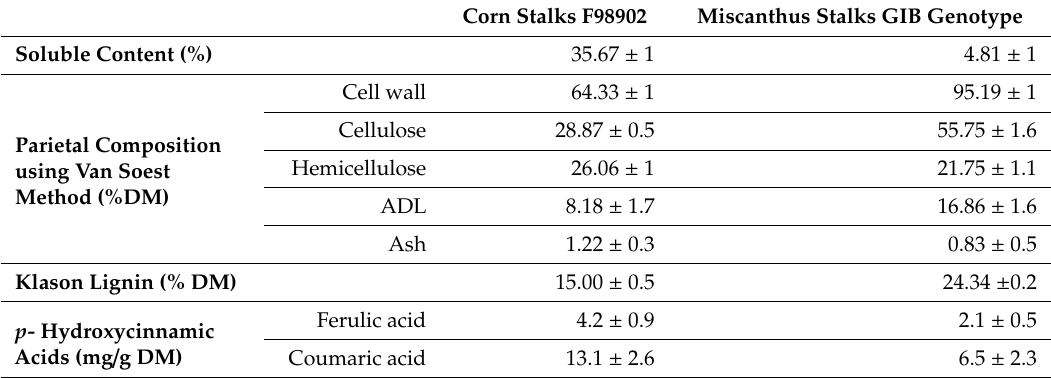
Table 1. Raw matter characteristics: parietal composition analyzed by Van Soest method and Klason lignin (mean of triplicate and standard error) and alkali extraction for ferulic acid (FA) and coumaric acids (CA) (mean of duplicate and standard error). ADL: acid detergent lignin, DM: dry matter. Corn Stalks